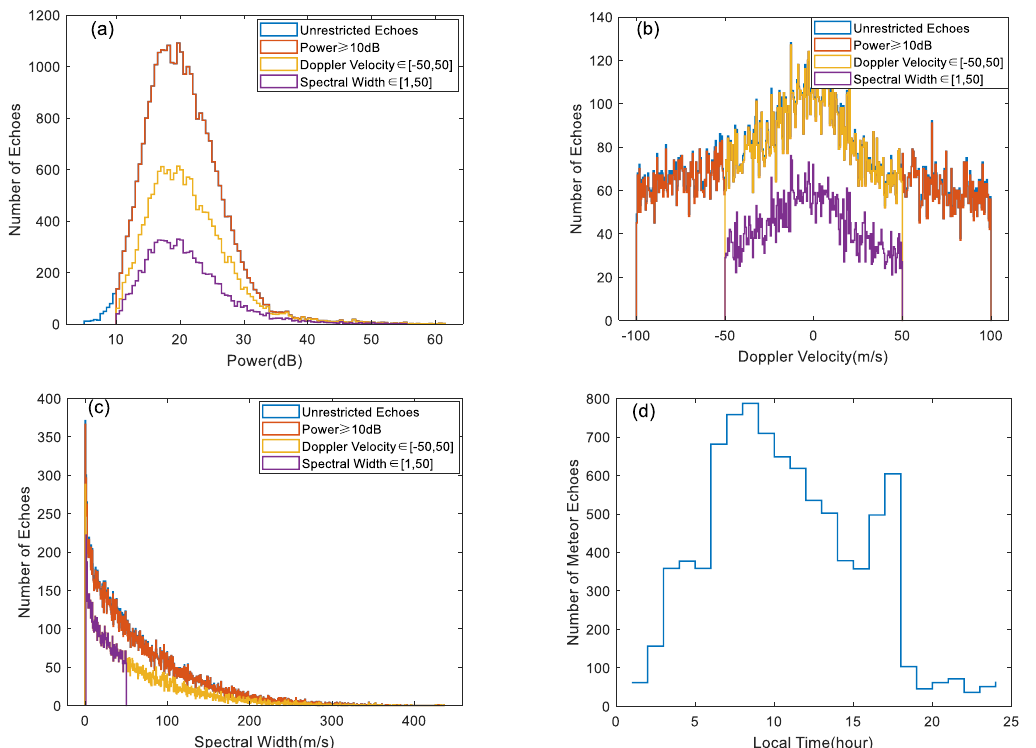
Figure 4. Histograms of the number of echoes extracted by the traditional algorithm. ( a ) Backscatter power distribution, ( b ) LOS Doppler velocity distribution, ( c ) Spectral width distribution, ( d ) The time distribution of the number of meteor echoes in 24 h.